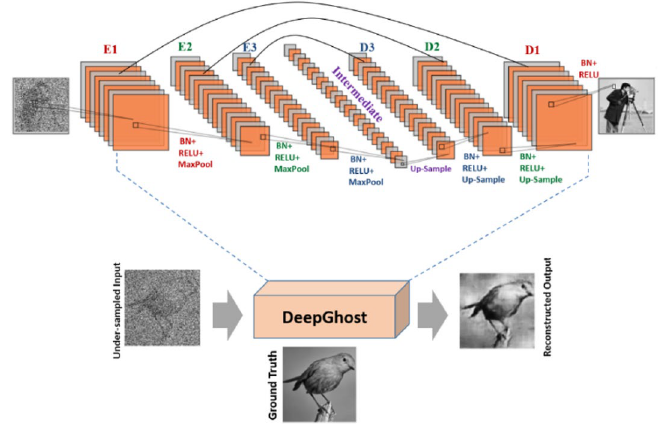
Figure 1. DeepGhost network architecture.